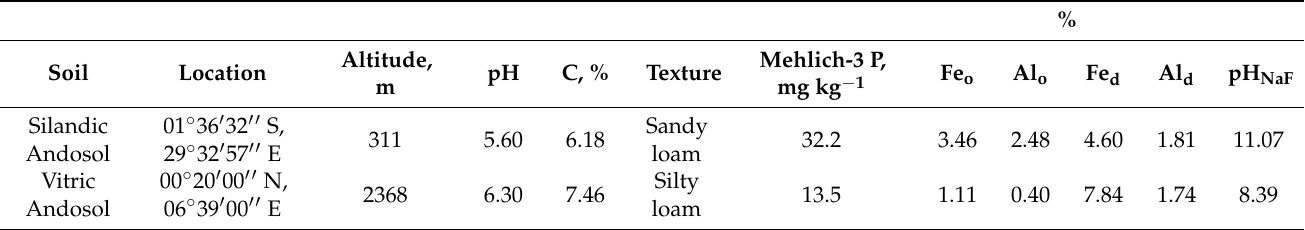
Values of pH in NaF higher than 9.5 indicate the presence of allophane and/or organo– aluminum complexes [53], materials active in the fixation of anions. Both soils showed high and hardly reversible phosphate sorption, somewhat higher in the Silandic Andosol [64]. The phosphate sorption isotherms conformed to the Temkin model. The soil samples were air-dried and sieved (<2 mm) prior to